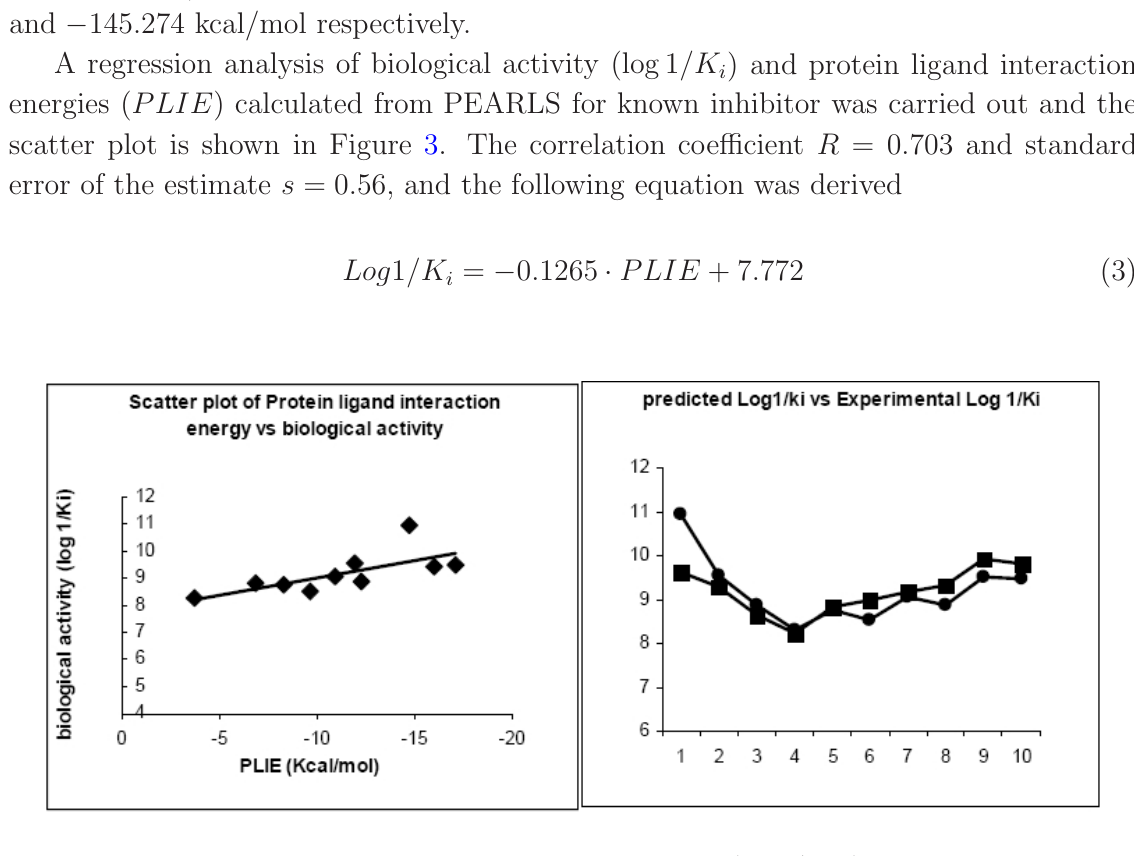
Fig. 3 Scatter plot of protein ligand interaction energy (kcal/mol) vs biological activity in log 1 /K i and plot of predicted biological activity vs experimental biological